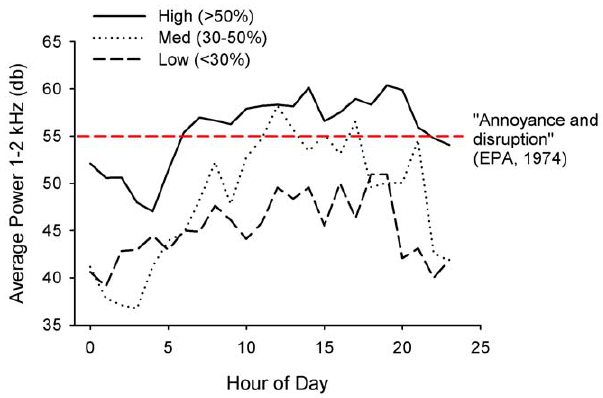
Figure 2. Temporal trends in anthropogenic sound by urban category. Average power (1–2 kHz) at lakes characterized as Low ( , 30%, n =3), Medium (30–50%, n =3), and High ( . 50%, n =4) urbanization. The threshold established by the U.S. Environmental Protection Agency (in dBA) for ‘‘outdoor annoyance and disruption’’ [7] is shown as a reference; dBA is highly comparable in this frequency range, with a weighting value of + 0–1.2 dB between 1–2 kHz; we have considered these equivalent for purposes of illustration.